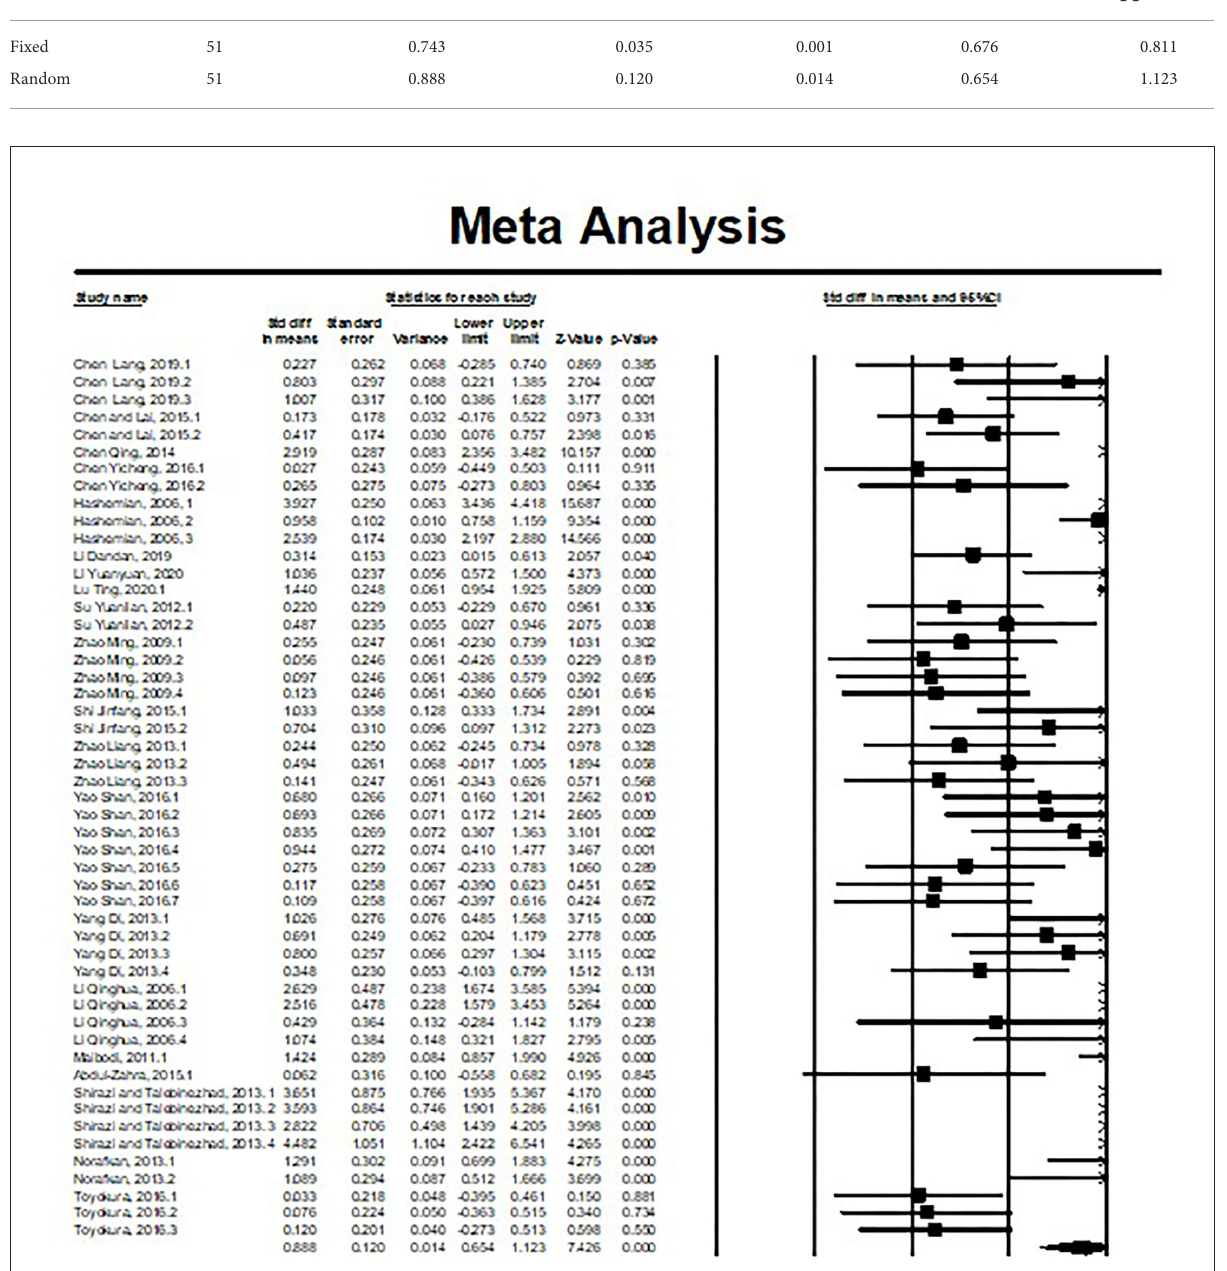
FIGURE3 Forest plot of the overall effect of instruction on metaphorical competence.